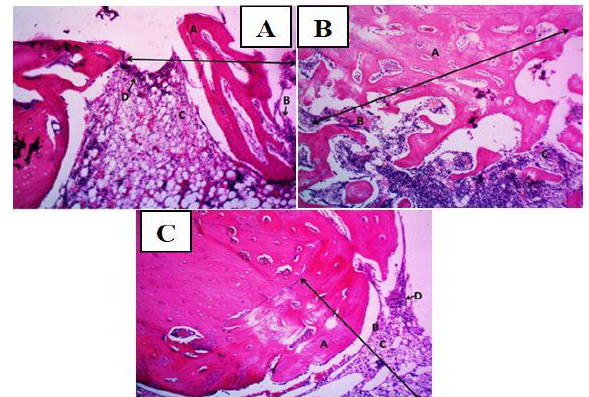
Fig. 2: Photomicrograph of femur bone of control (A); local treated (B) and systemic treated group (C) at 28 days shows the site of the hole (↔) with the presence of well-developed new trabecular bone formation not fill the hole area, woven bone , connective tissue formation and inflammation (score 1). H&E stain,